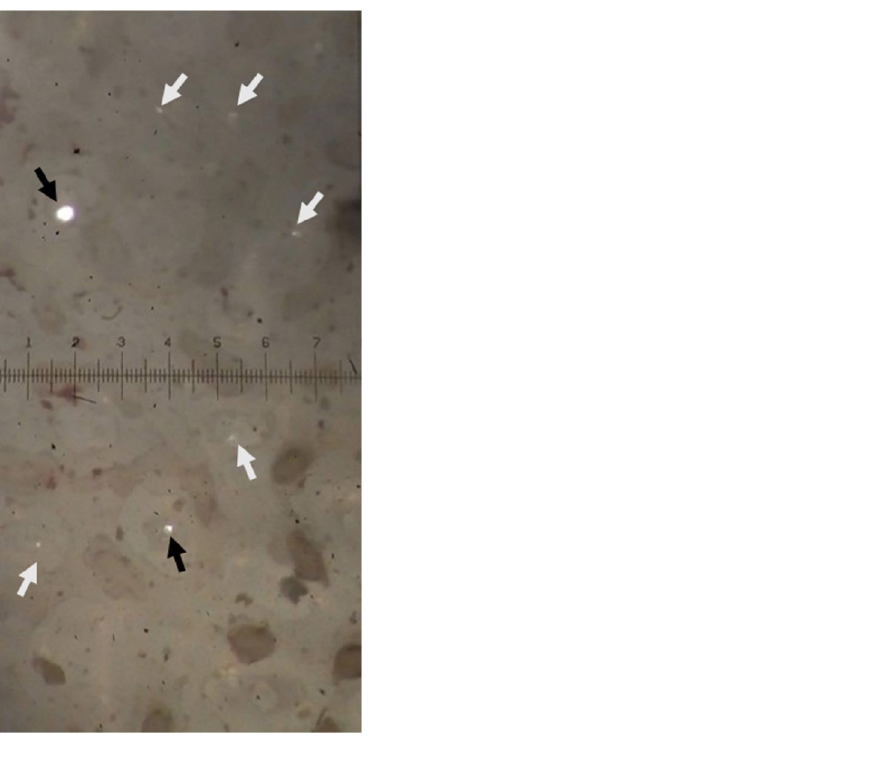
Figure 6. Eggshell displayed under magnifying glass (50×) in top view in backlight. Open pores are indicated by black arrows; closed pores with white arrows. The dark spots are the columns that can be joined to form bridges.